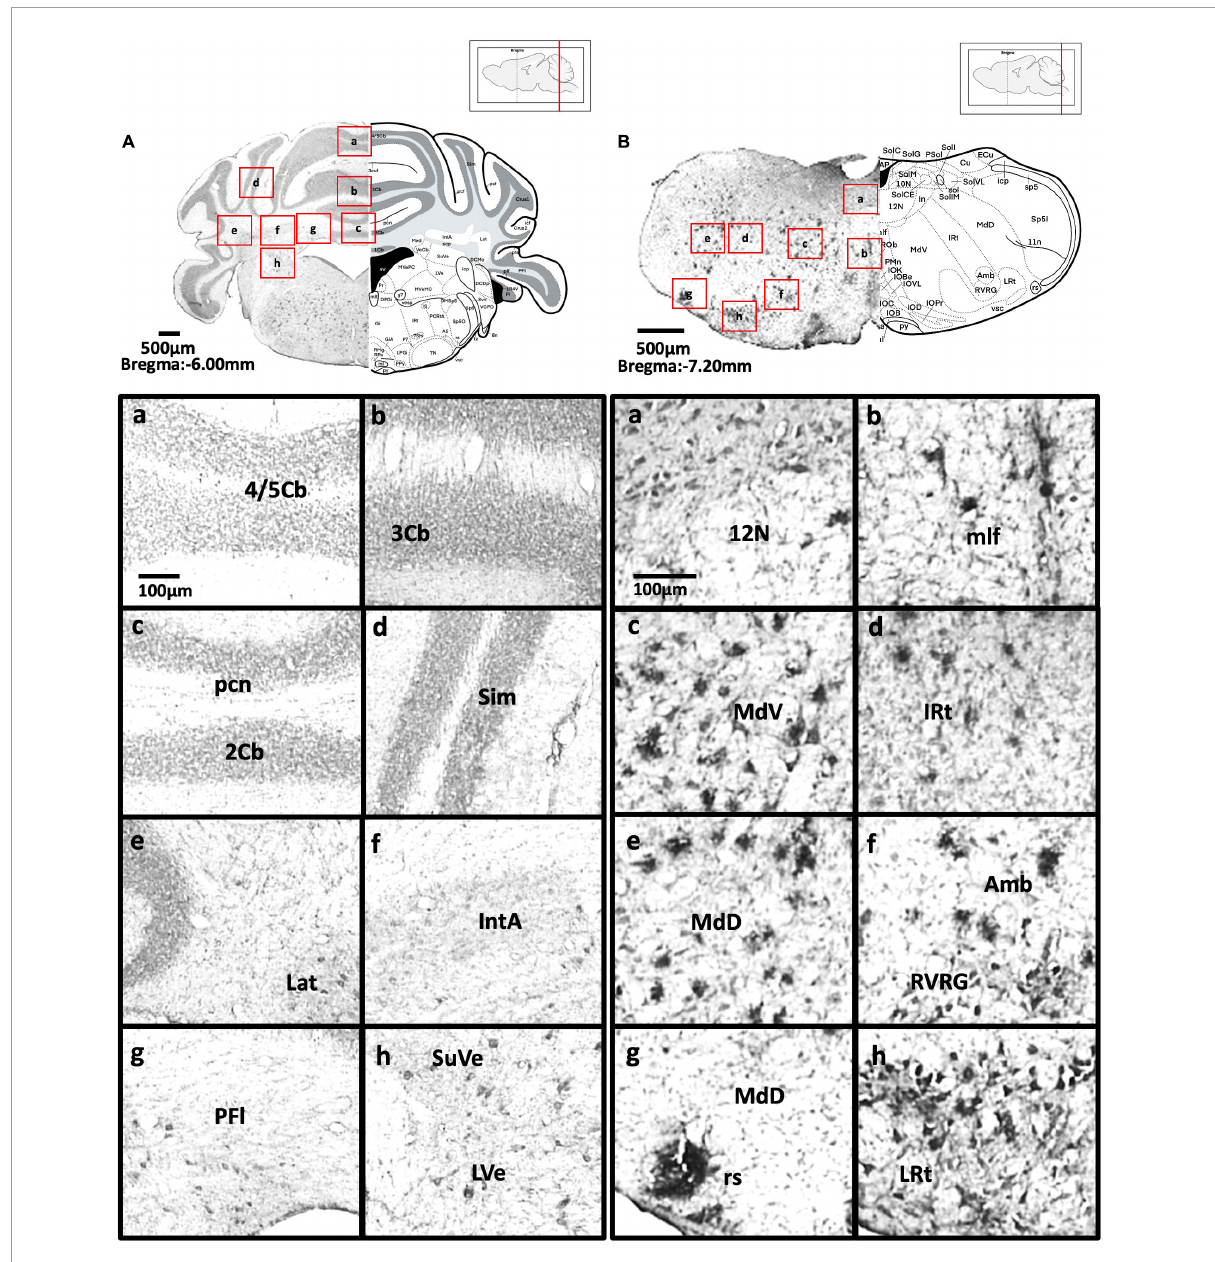
FIGURE8 (A) Coronal section through the cerebellum and medulla showing A β deposition in lobules 4 and 5 of the cerebellar vermis (a), lobule 3 of the cerebellar vermis (b), lobule 2 of the cerebellar vermis and precentral fissure (c), simple lobule (d), lateral cerebellar nucleus (e), anterior interposed cerebellar nucleus (f), paraflocculus (g), superior vestibular nucleus, and lateral vestibular nucleus (h). (B) Coronal section through the spinal cord showing A β deposition in the hypoglossal nucleus (a), medial longitudinal fasciculus (b), ventral medullary reticular nucleus (c), intermediate reticular nucleus (d), dorsal medullary reticular nucleus (e), ambiguus nucleus and rostral ventral respiratory group (f), rubrospinal tract and dorsal medullary reticular nucleus (g), and lateral reticular nucleus